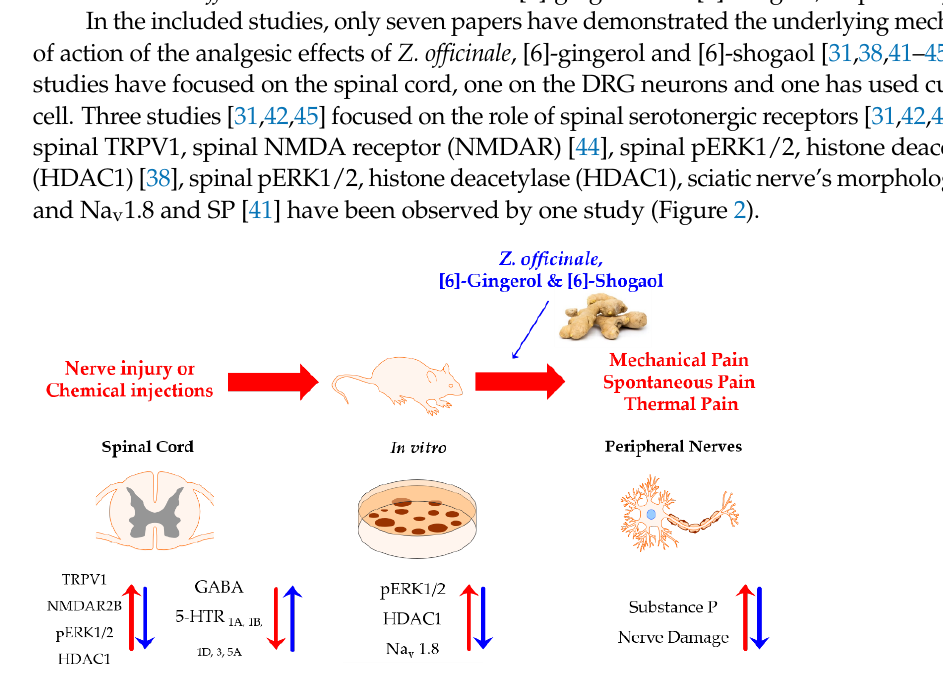
Figure 2. The pathogenesis mechanism of pain induced by nerve injury or chemical injection and the mechanism of action of the analgesic effect of Z. officinale , [6]-gingerol and [6]-shogaol. Pain is caused by nerve injury or chemical injection (Red), and pain is attenuated when Z. officinale and its sub-components are administered (Blue). Mechanism was identified on the spinal cord, peripheral nerves and cultured cell (in vitro). Abbreviations:5-HTR (serotonin receptor), GABA (gamma-aminobutyric acid), HDAC1 (histone deacetylase 1), Na v 1.8 (voltage-gated sodium channel 1.8), NMDAR2B (N-methyl-D-aspartate receptor subunit 2B), pERK (phosphorylated extracellular signal-regulated kinase), TRPV1 (transient receptor potential vanilloid 1), and Z. officinale ( Zingiber officinale Roscoe).